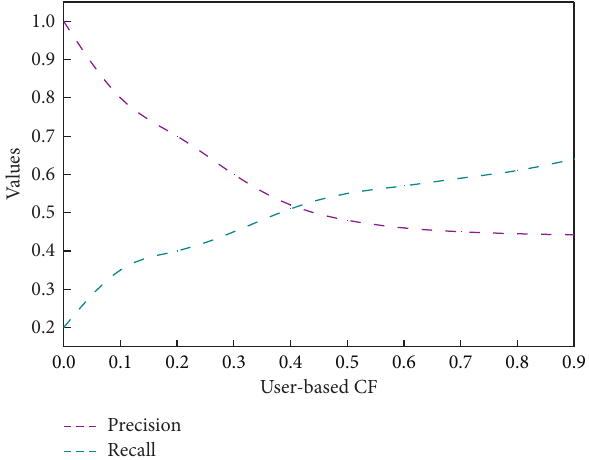
Figure 4: Plot of learner-based collaborative filtering recall vs. precision.